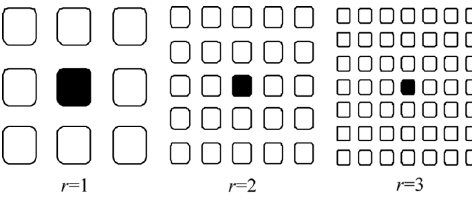
Fig. 2. The neighborhood of cell C ( i , j ) for r = 1, r = 2 and r = 3,